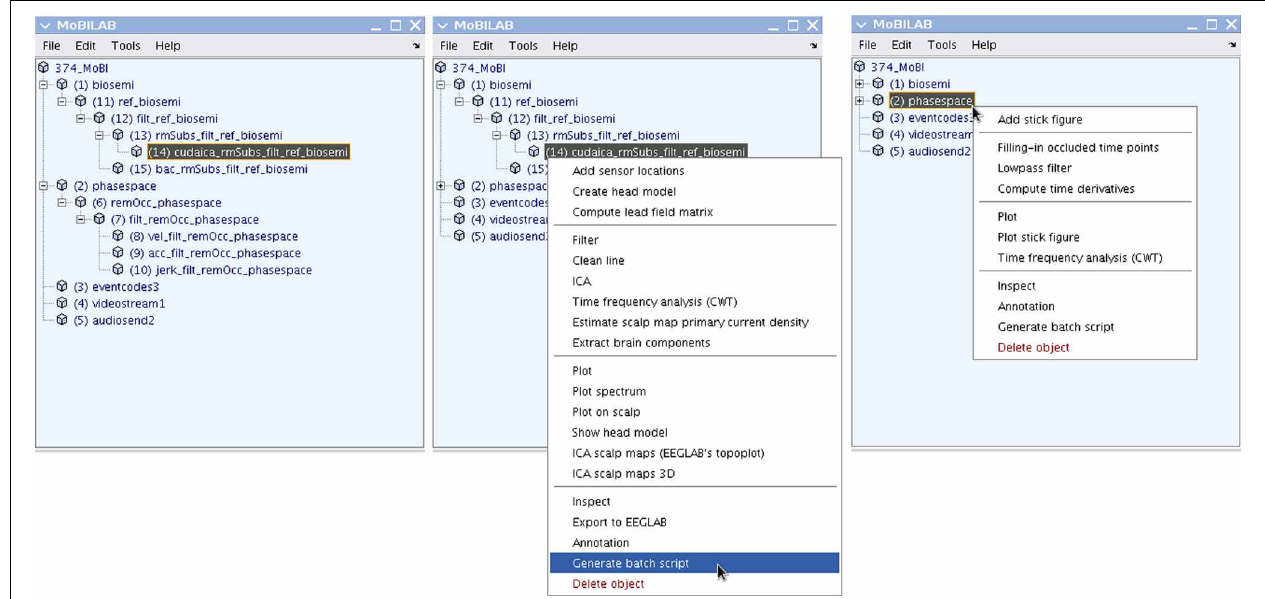
FIGURE 4 | The MoBILAB GUI and processing pipelines. The left panel shows the tree of parent-children relationships among data objects in a loaded multi-stream MoBI dataset. The integers enclosed in parentheses to the left of each object name give the index in the cell array mobilab.allStream.item . The two branches shown unfolded (by clicking on the data object names, here biosemi and phasespace ) represent two